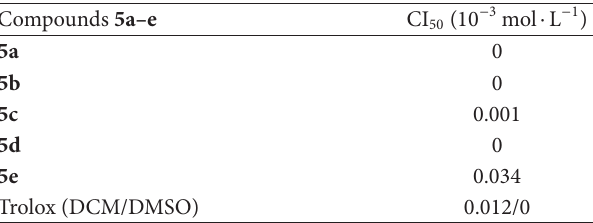
T 4: e EC 50 values exhibited by 2-amino-3-ethoxycarbonyl- 4-(aryl)-4H-pyrano-[3,2-c]-chromene-5-ones 5 . Compounds